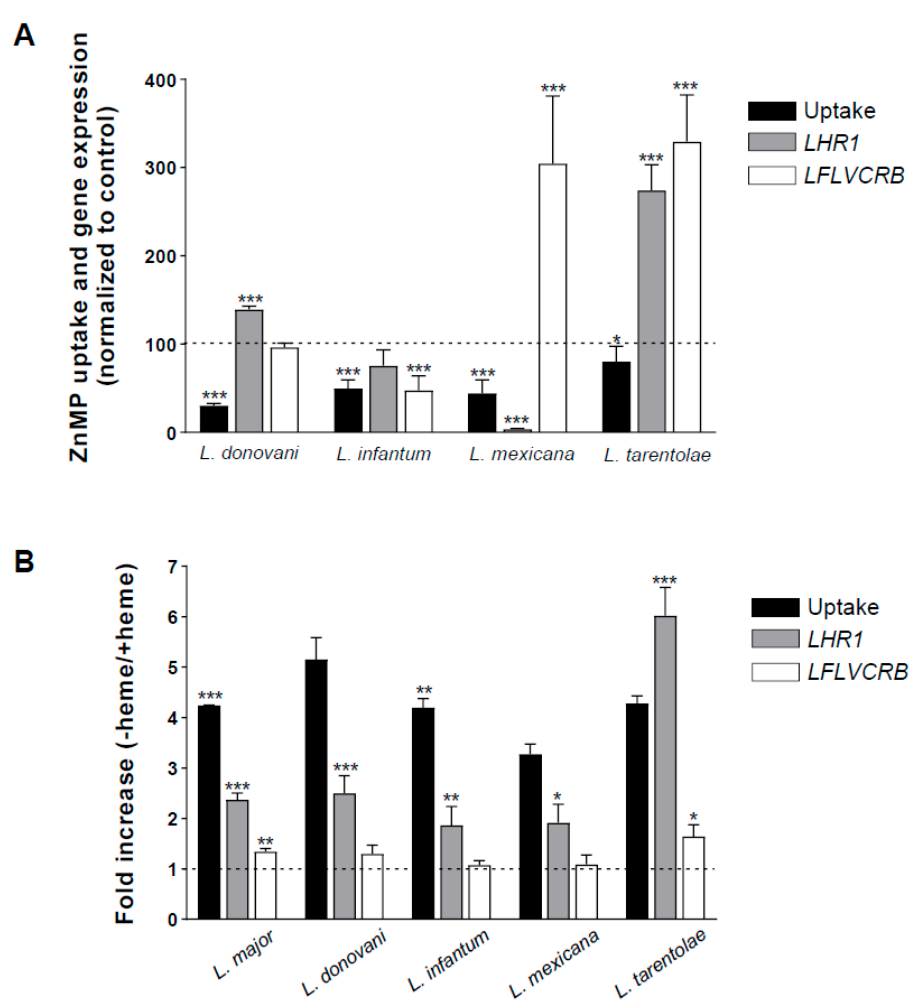
Figure 5. ZnMP uptake and heme transporters expression levels in different Leishmania spp. Pro- mastigote forms of the indicated Leishmania species were cultured in 10% FBS-supplemented medium ( A ) or 20% hdFBS-supplemented medium containing or not 10 µM heme ( B ). Net ZnMP uptake was measured using flow cytometry after 10 min incubation with 10 µM ZnMP (black bars) as described in Materials and Methods. The LHR1 mRNA (gray bars) and LFLVCRB (white bars) expression levels were analyzed by qRT-PCR as described in Materials and Methods. Fold increase ( − heme/+heme) represents the ratio of ZnMP uptake or gene expression in absence of heme relative to the presence of heme in the culture medium. Data in ( A ) were represented as percentage of the values found in L. major (dashed line). The experiment was performed three times in duplicate, and data expressed as mean ± SEM. p ≤ 0.05 (* p ≤ 0.05, ** p ≤ 0.005, *** p ≤ 0.0005) was considered statistically signifi- cant.In ( A ), significance analysis was performed comparing each value with that of L. major , whereas, in ( B ), it was performed comparing results with or without